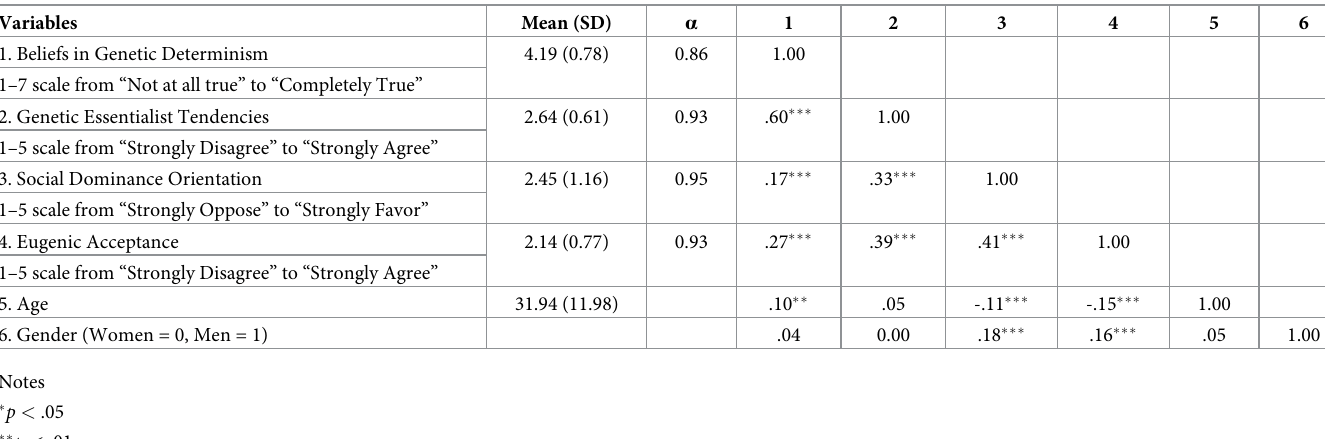
Table 1. Means, alphas, and bivariate correlations for all variables in Study